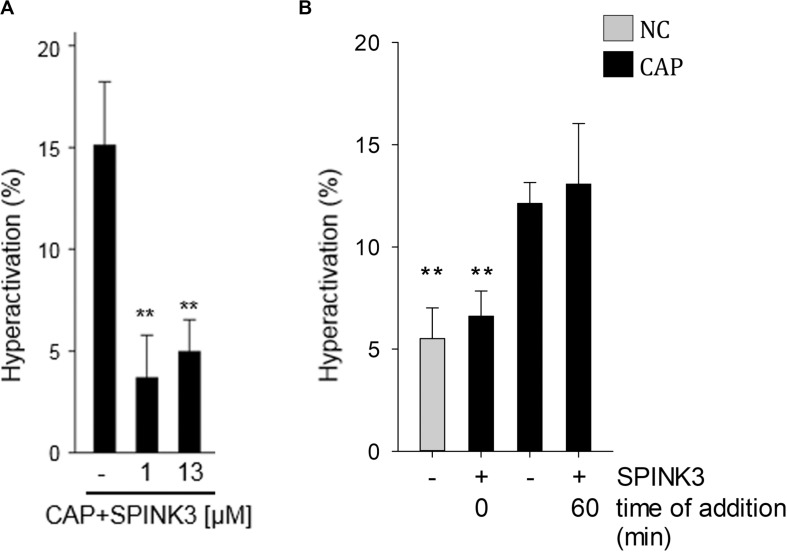
Effect of SPINK3 on hyperactivation. (A) Mouse sperm were incubated in the absence or presence of different SPINK3 concentrations in medium that supports capacitation (CAP). Hyperactivation was analyzed using a Hamilton Thorne IVOS CASA system (data represents mean ± SE, n = 3; **p < 0.01 with respect to CAP control). (B) Sperm were incubated under non-capacitating (NC) or capacitating (CAP) medium for 75 min, and 1 μM SPINK3 was added either since the beginning (0 min) or at the end (60 min) of the capacitation period (data represents mean ± S.E.M., n = 3; **p < 0.01 with respect to CAP control).